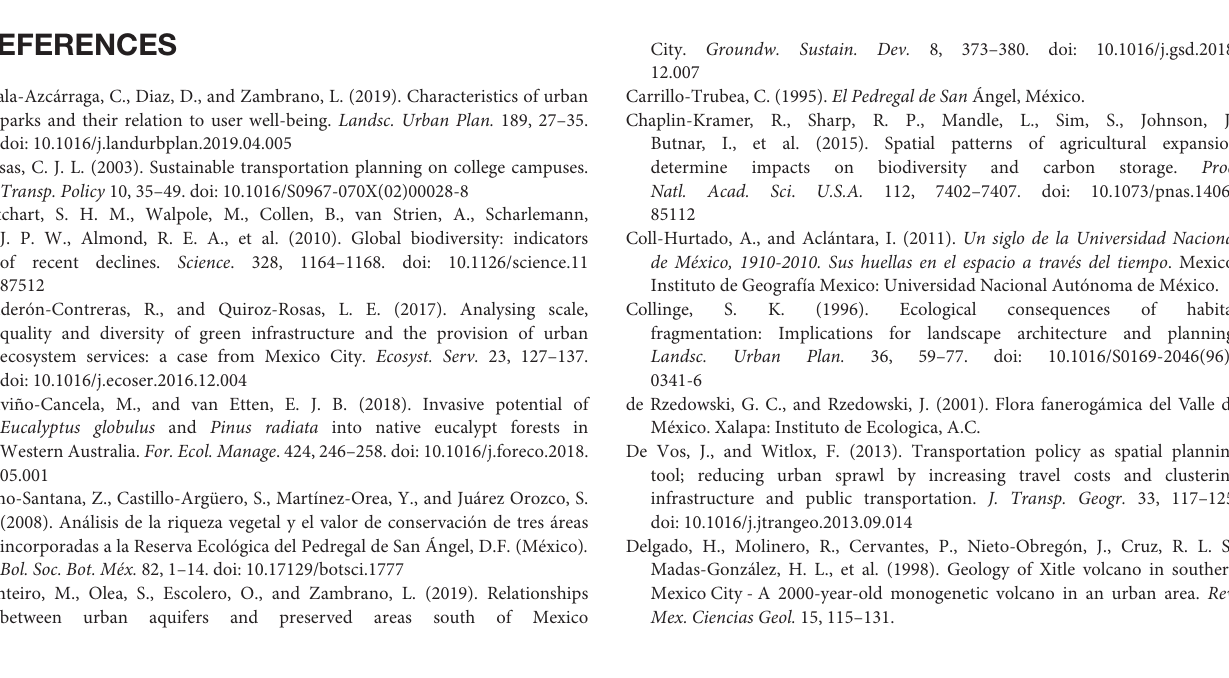
Supplementary Table 1 | Repeated measures analysis of each category along years. Annex 1 | Pictures of the described ecosystem in dry (1) and wet season